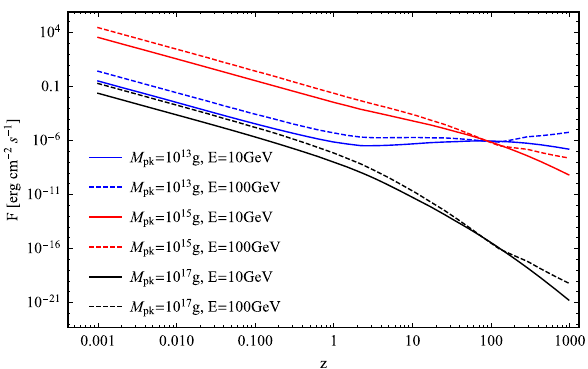
Fig. 2 Theobservedphotonflux F ofaPBHbubbleofphysicalvolume 1Mpc 3